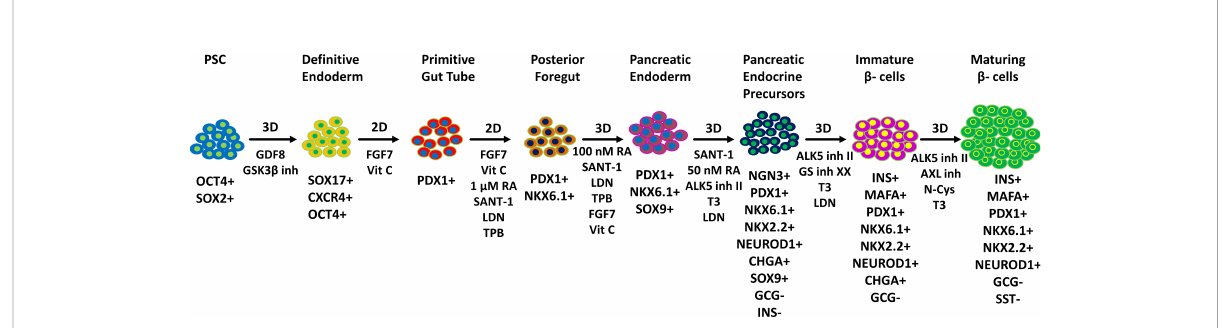
FIGURE 1 Differentiation protocols of pancreatic b -cells from human iPSCs. Through mimicking the normal human pancreas development, directed differentiation protocols via adding different growth factors and small molecules can induce human iPSCs into pancreatic b -cells in vitro . This fi gure summarizes the 7-stage differentiation protocol and key markers of the differentiation pancreatic cells for evaluation of the consecutive stages of differentiation [(mainly based on references (20,